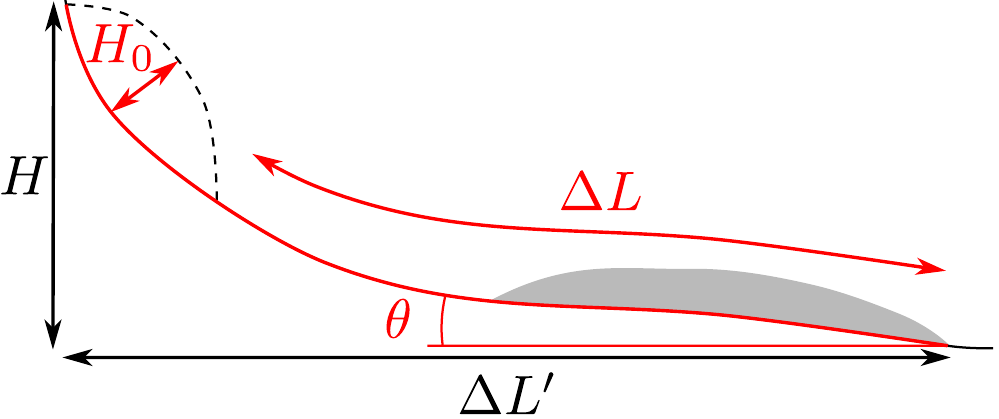
Figure 1. Parametrization of landslide mobility, with notations as in [5]. Dashed line: initial mass. Grey shaded are: final landslide deposits. H is the drop height, ∆ L (cid:48) the horizontal travel distance. H 0 is the mass initial thickness, ∆ L the travel distance along topography from the landslide scar toe, and θ is the average slope angle along the flow path. The notations in red are used for µ ef f , and in black for µ H